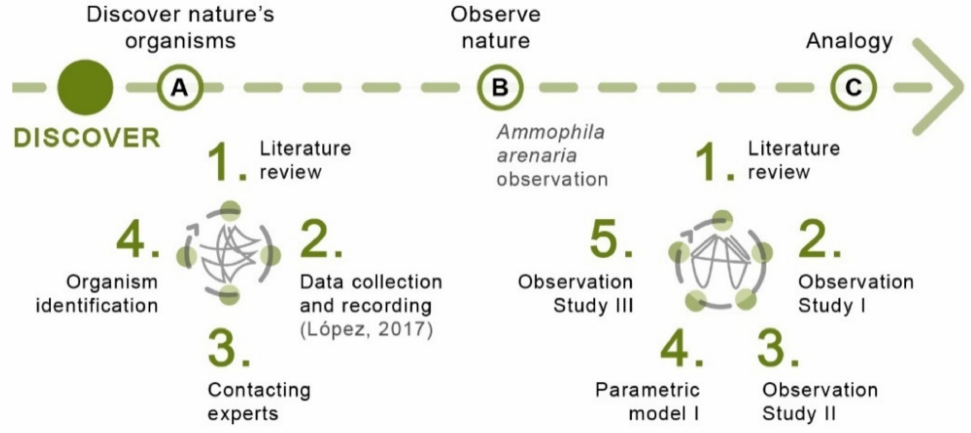
Figure 2. Phases in the research methodology. Source: Authors.